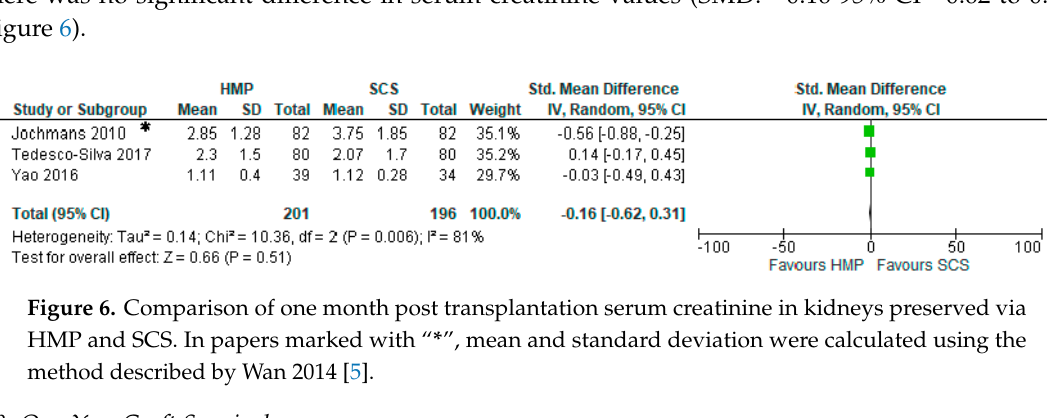
Figure 7. One year graft survival in kidneys preserved via HMP and SCS. 3.9. Post-Transplant Estimated Glomerular Filtration Rate in HMP and SCS Kidneys. One of our previous studies [7] as well as the one from Tedesco et al. [24] were the only two that reported eGFR at more than one time point after the surgery. Combined meta-analyses of 200 patients demonstrate that HMP increased eGFR only on day 7 post surgery (SMD: 0.39 95% CI 0.11 to 0.67, p = 0.007) (Figure 8). There was no significant difference in eGFR of kidneys preserved with HMP and SCS both on day 14 (SMD: 0.99 95% CI − 0.26 to 2.24, p > 0.05) (Figure 9) and day 365 (SMD: 0.6 95% CI − 0.19 to 1.38, p > 0.05) (Figure 10). Figure 8. Estimated glomerular filtration rate (eGFR) in kidneys preserved via HMP and SCS; eGFR day 7.